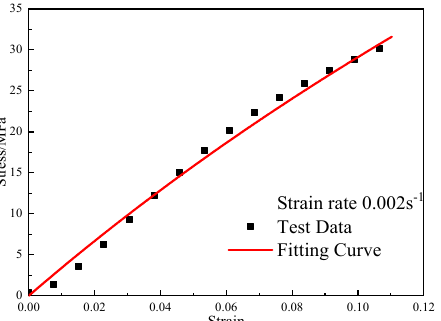
Figure 13. The fitting results of the ZWT constitutive model under low strain rate. The stress–strain curves of No.13 and No.21 with different strain rates are fitted so as to obtain the elastic constant E 2 and relaxation time θ 2 , which is suitable for strain rates ranging from 1400 s − 1 to 2600 s − 1 when the pressing pressure is 400 MPa. The fitting results are shown in Figure 14. The correlation coefficients R 2 of curve fitting are 0.99 and 0.98, respectively. The fitting results are E 2 = 719 MPa and θ 2 = 2.09 µ s.